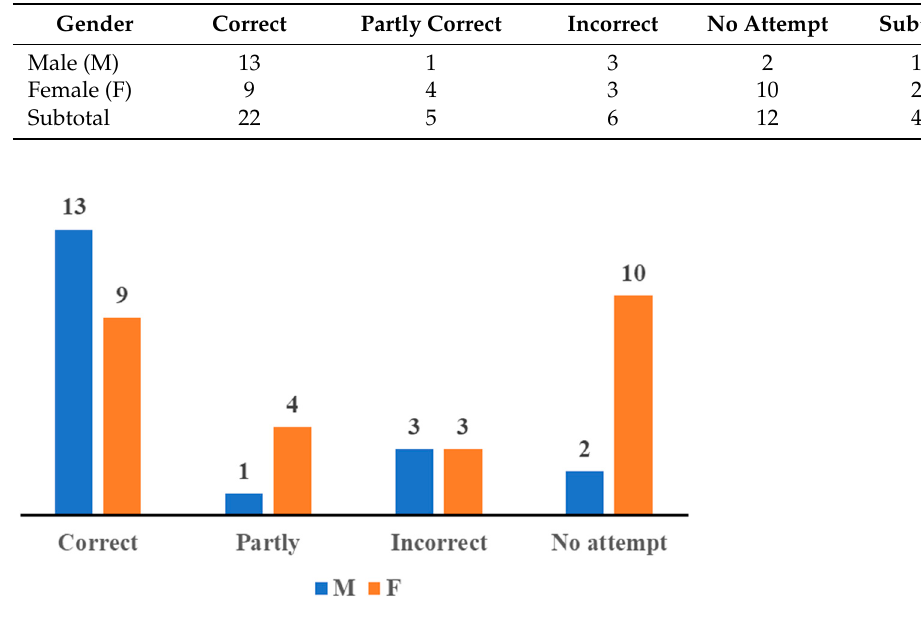
Table 10. Results of chi-test on student’s results and actions from the two age groups.